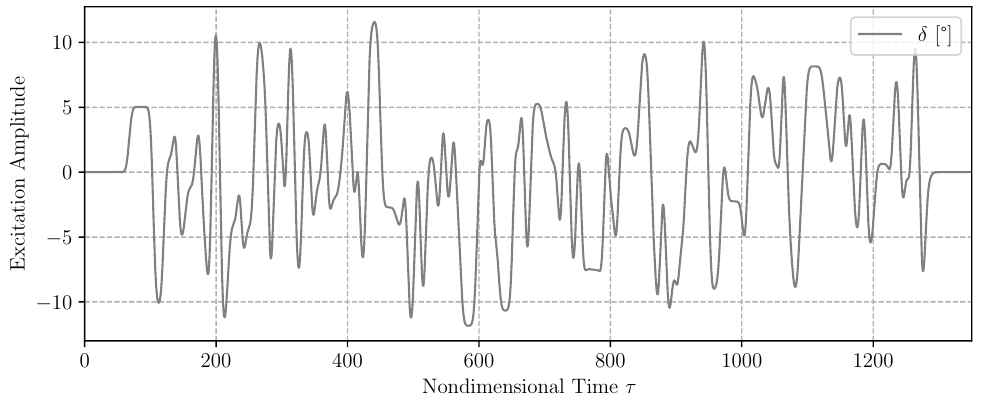
Figure 5. Time series of the training signal (APRBS) for the excitation of the ailerons structural degree of freedom.